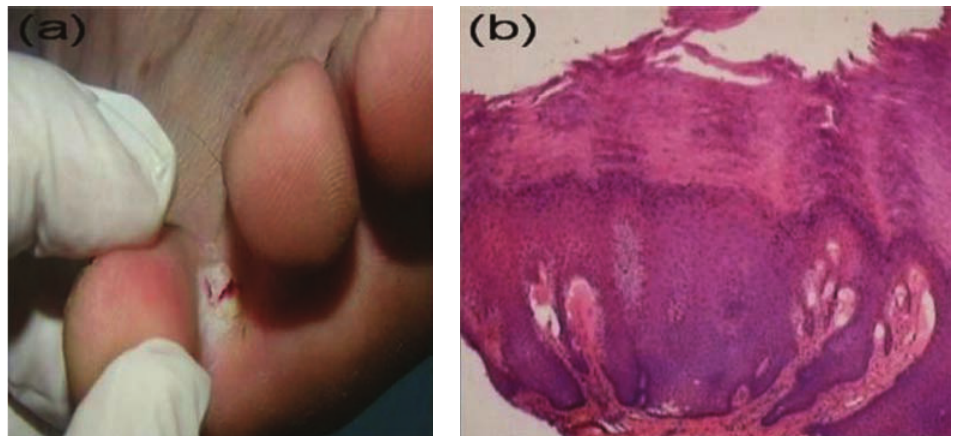
Figure 4: Interdigital wart. (a) Interdigital whitish plaque with well-defined border. (b) The punch biopsy shows changes characteristic for a common wart (H&E, × 100).